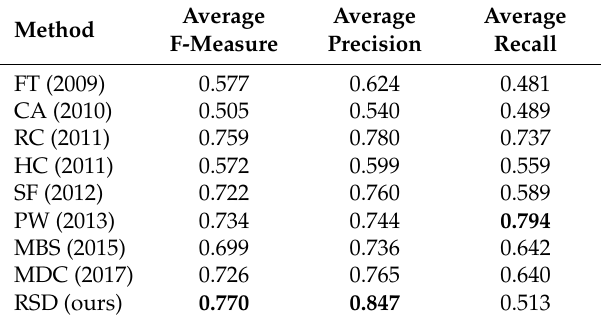
Table 3. Average performance on the three datasets used. The model with the highest performance on each metric is highlighted in